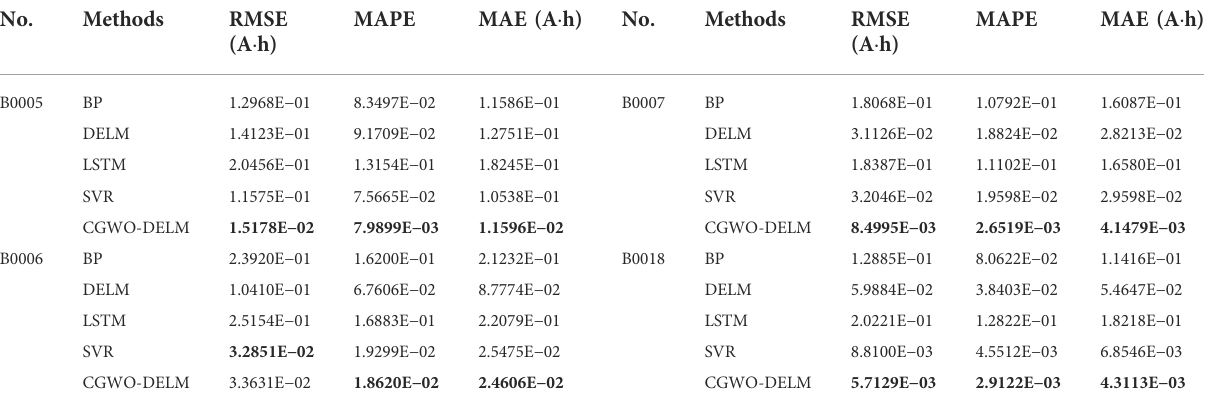
TABLE 5 Comparison of evaluation indexes (the fi rst 60 cycles of data are used as the training set). No.